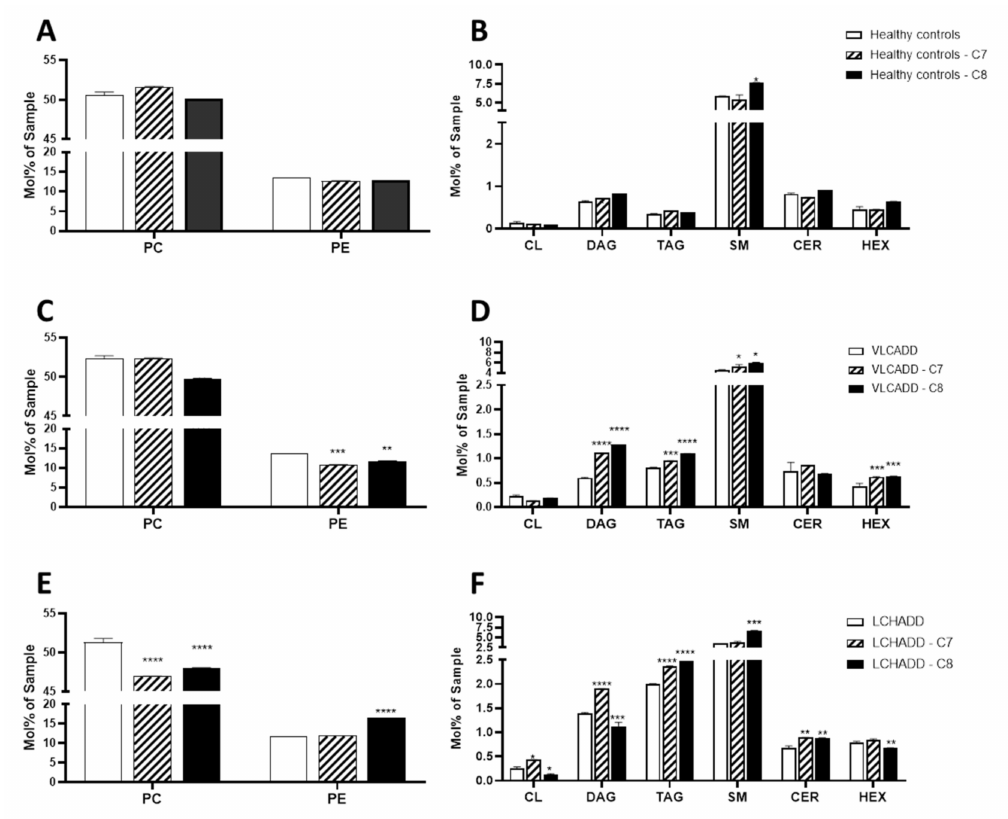
Figure 1. Effect medium-chain fatty acids on the lipidome of fibroblasts from healthy controls ( A , B ), VLCADD ( C , D ) and LCHADD ( E , F ). Mol% sample: indicates the moles of the lipid species extracted from one sample calculated as percentage of the total amount of lipid extract. PC: phosphatidylcholine; PE: phosphatidylethanolamine; SM: sphingomyelins; CL: cardiolipins; DAG: diacylglycerides; TAG: triacylglycerides; CER: ceramides; HEX: hexosylceramides; values denoted by * were considered significant if p < 0.05, ** p < 0.005, *** p < 0.0005, **** p < 0.0001 (two way ANOVA, genotype and diet were used as independent factors; Mann-Whitney test; Friedman test and Tukey’s Test); * indicates significant differences between healthy controls and diseases. Lipid values under control conditions were retrieved from Alatibi et al.